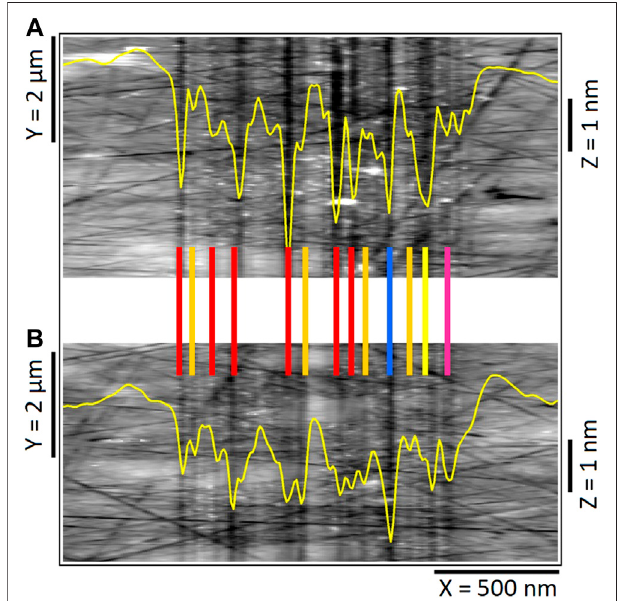
FIGURE 5 | Comparison of scratches in two consecutive wear scars. Topography sections of the fi rst (A) and the second (B) track are shown together with their line pro fi les averaged over the whole track length and superimposed onto the topographies. The blue line marks a deeper unchanged scratch, green lines mark shallow unchanged scratches, red lines tag fl attenedones,theyellowlineindicateasplitscratch,andthemagentaone denotes the merging of two